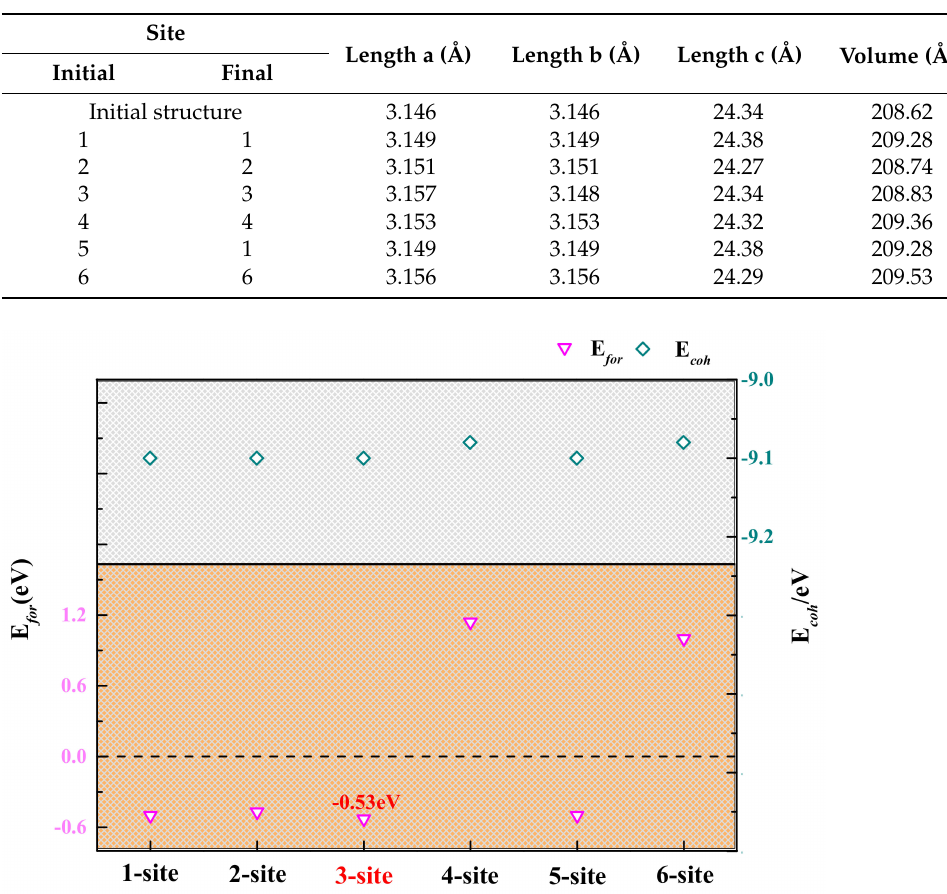
Table 1. The changes of crystal structure for H incorporation into different interstices of Nb 4 AlC 3 .